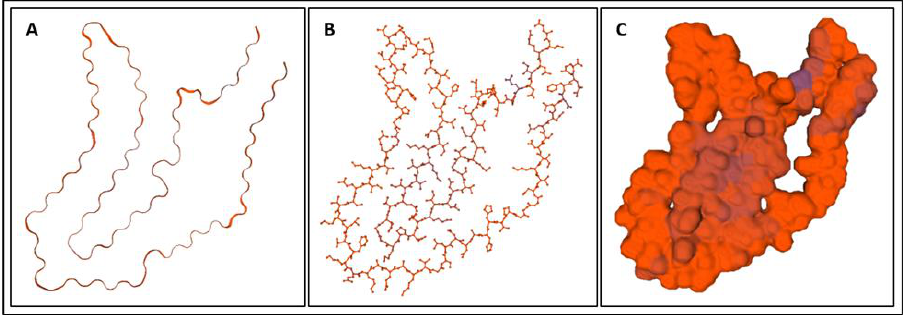
Figure 4. ( A ) A cartoon model, ( B ) a ball-and-stick model, and ( C ) a surface model of MAP-2 [28].